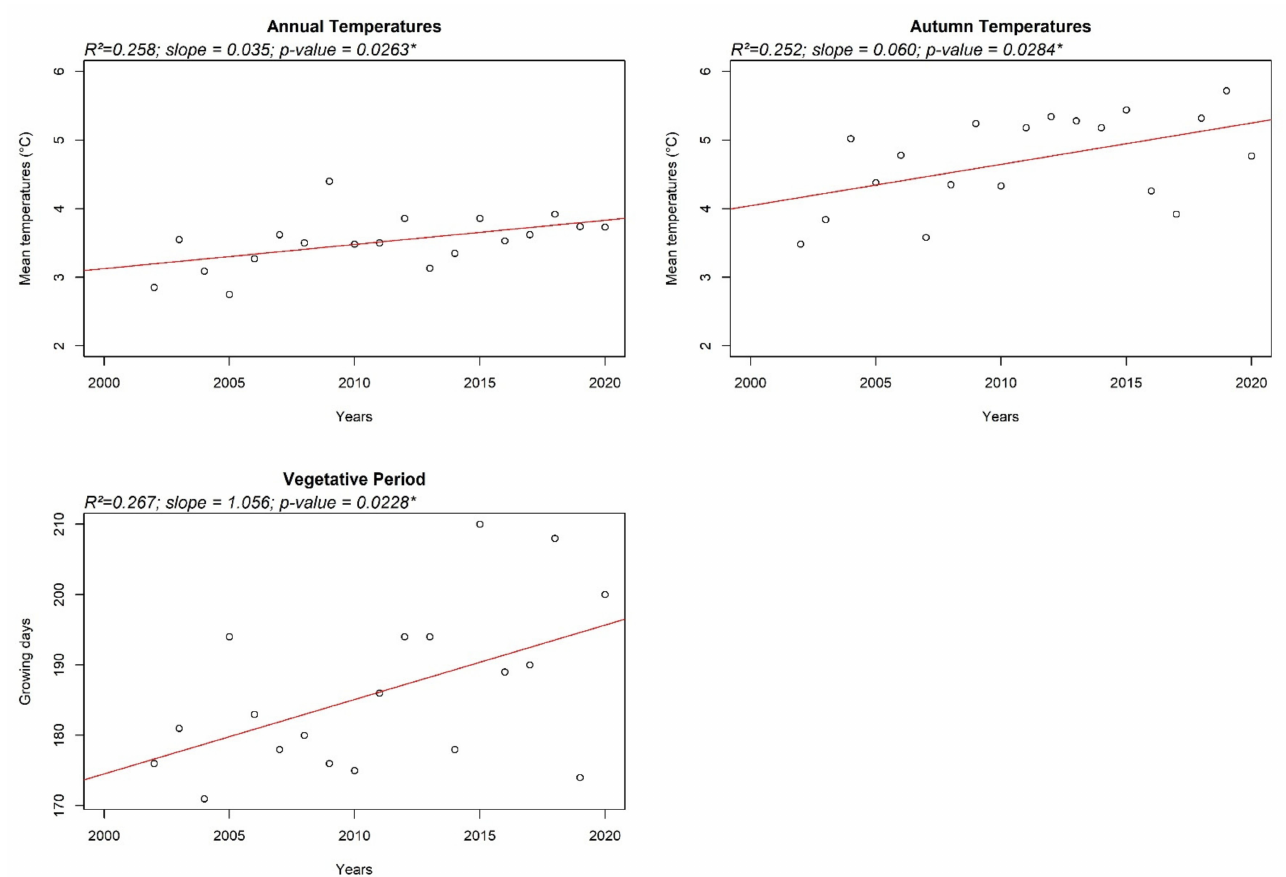
Figure 2. Annual and autumn (September–November) mean soil temperatures ( ◦ C) and vegetative period (e.g., the number of days with temperatures above 2 ◦ C) for the period 2002 to 2020. Asterisks indicate significant trends. Data were retrieved from data-loggers of GLORIA monitoring network (Global Observation Research Initiative in Alpine Environments) IT CAM FEM (2405 m